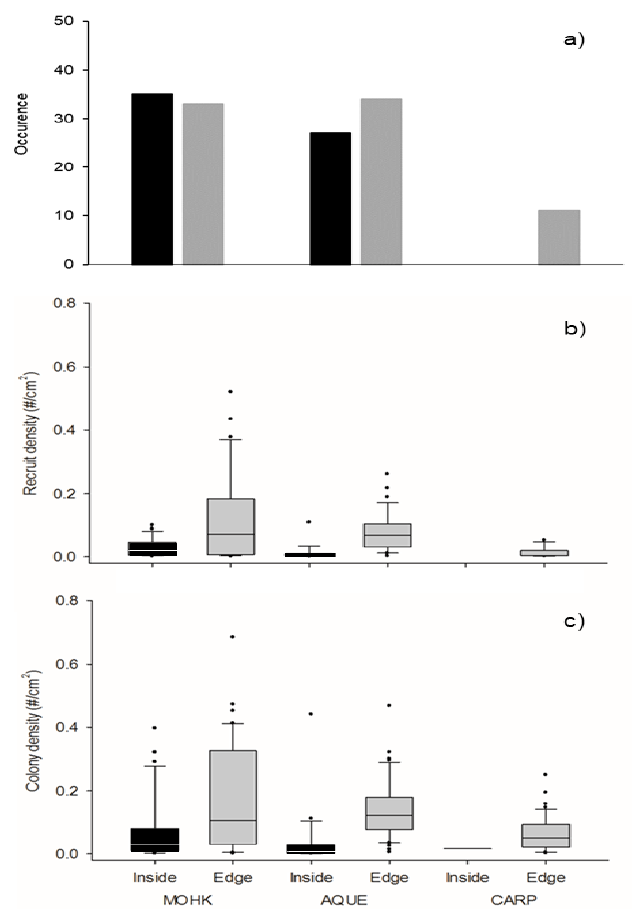
Figure 2. ( a ) Occurrence of Membranipora recruits on kelp blades, ( b ) density of Membranipora recruits on occupied blades, and ( c ) density of all Membranipora colonies on kelp blades. Grey bars indicate edge locations and black bars indicate interior locations at the three sites. Box plots show the median (central line), 25th and 75th percentiles (bottom and top of bars), and 5th and 95th percentiles